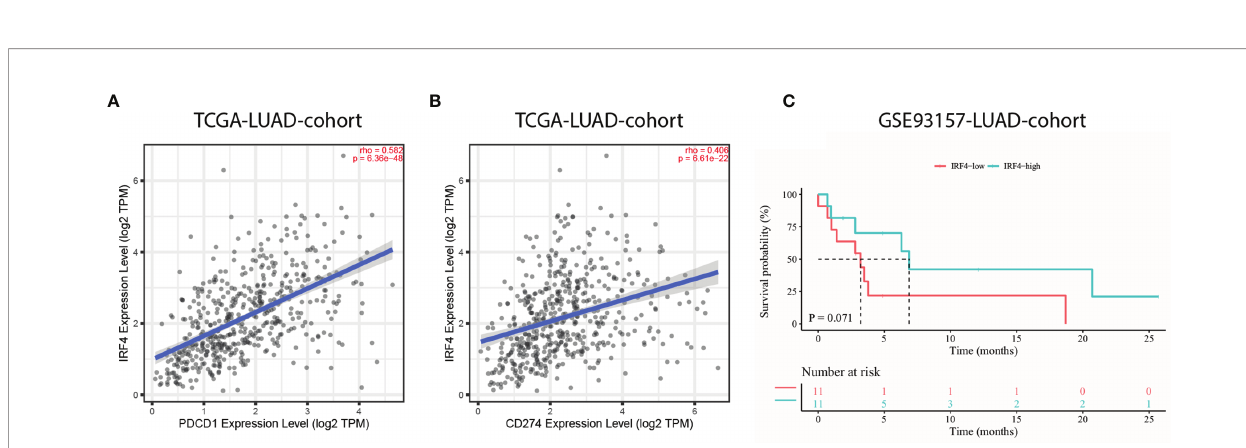
FIGURE 5 | Representative IHC images of LUAD patients. (A) The sample from IRF4-low group was stained by IRF4, CD8, CD4 and CD20 antibodies. (B) The sample from IRF4-high group was stained by IRF4, CD8, CD4 and CD20 antibodies. Left panel: 10x magni fi cation; Right panel: 40x magni fi cation. LUAD, Lung adenocarcinoma.